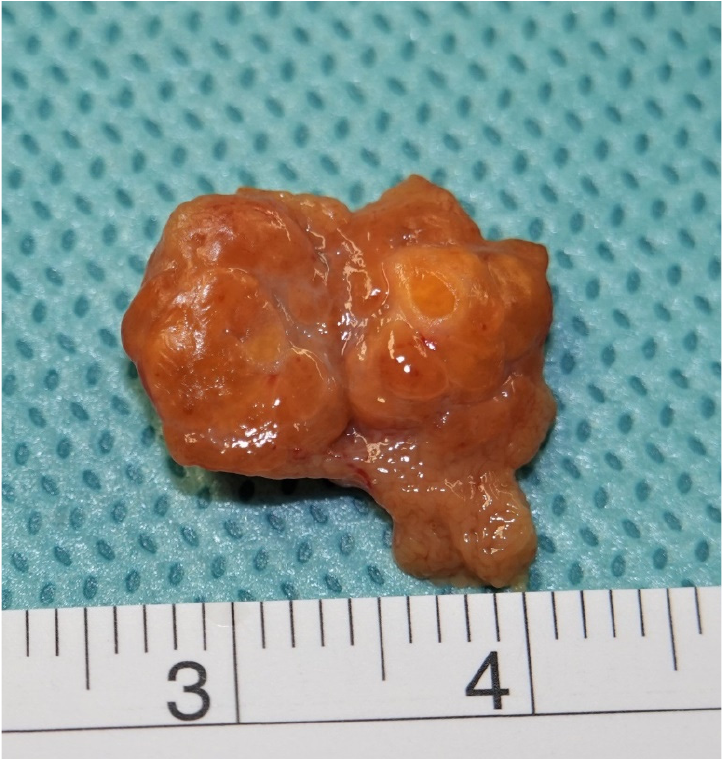
Figure 2. Typical subcentimeter testicular neoplasm. Surgical specimen of a 6 mm sized benign Leydig cell tumour excised by testis sparing surgery.